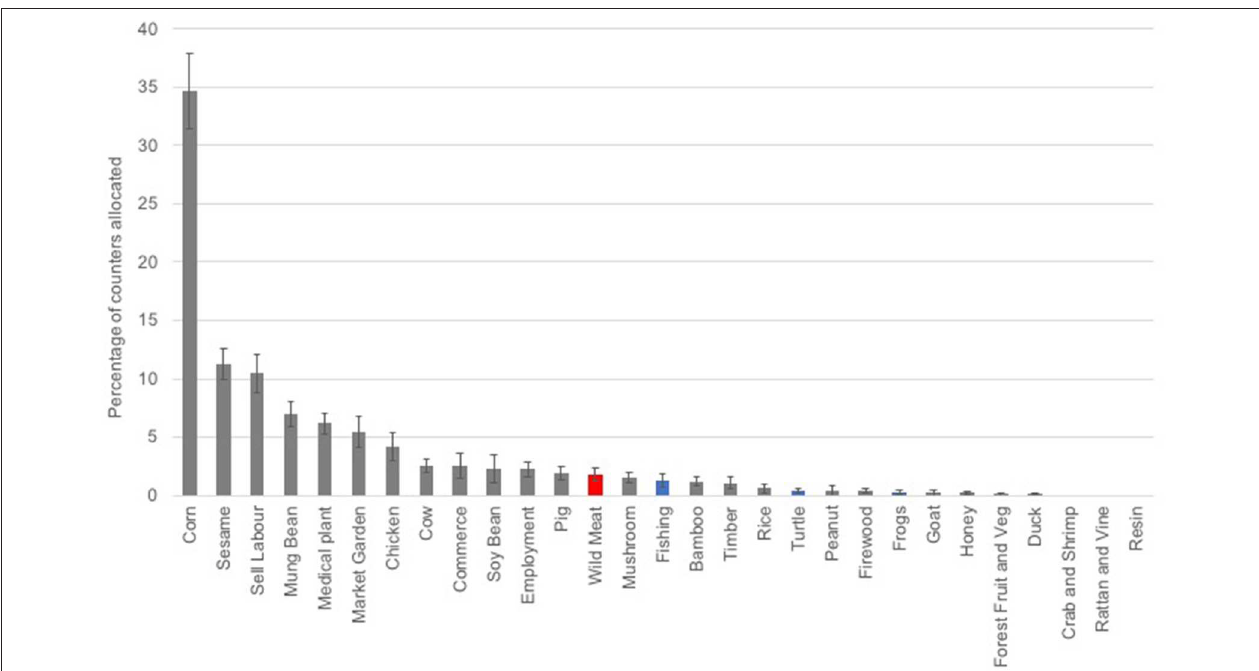
FIGURE 2 | Average cash-income scores per household given for agricultural, NTFP, and fishing products during the PRA exercise. Bars show average percentage of counters allocated to each product/activity, with associated standard error. N = 36 households. Scores for each village are provided in Supplementary Material S9